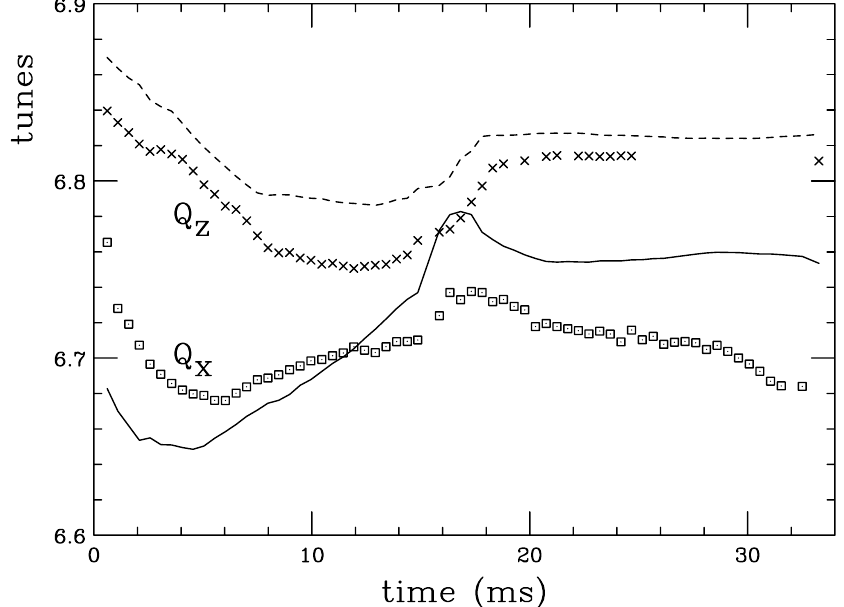
FIG. 9. The horizontal (square) and vertical (cross) betatron tunes in a booster cycle. Tunes calculated by MAD model are compared to measurements (solid and dashed